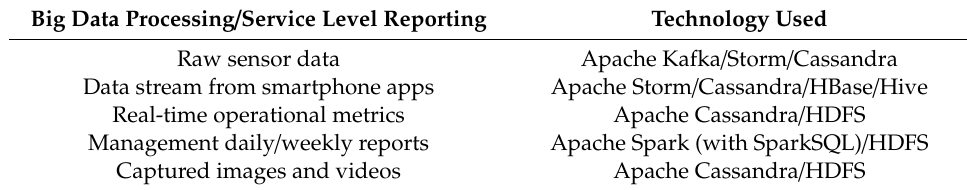
Table 3. Technologies used for big data processing in di ff erent layers of